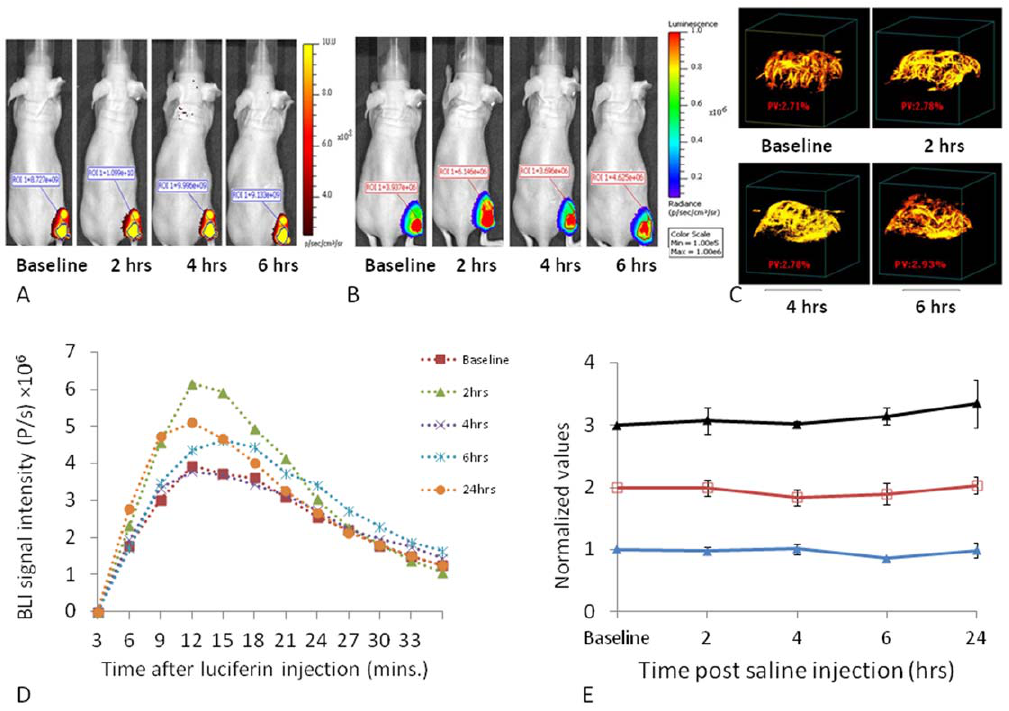
Figure 3. Reproducibility of sequential images in MCF7-mCherry-luc tumors. A group of nine MCF7-mCherry-luc tumors was repeatedly observed by FLI, BLI, and PD US following injection of 100 m l saline IP. A) Sequential FLI for a representative mouse, B) BLI from the same mouse showing images acquired 10 mins after administration of fresh luciferin on each occasion, c) PD US showing MIP (maximum intensity projection) observed at 40 MHz, D) Variation in dynamic bioluminescent signal intensity from the same tumor as in A,B and C, on five sequential occasions over 24 hrs, E) Comparison of signal stability based on FLI (red % ), BLI (blue m ) and PD-US (black m ) normalized values are presented mean 6 SE for the whole